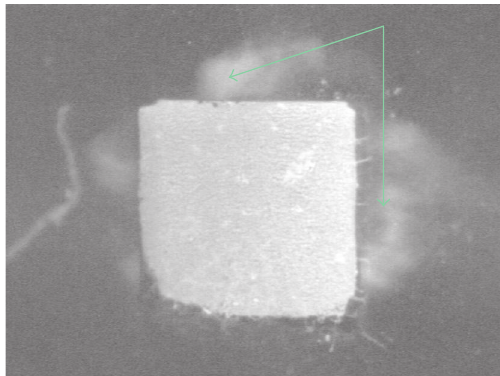
Figure 2: Collagen film surface after laser treatment ( F = 0 . 7 J/cm 2 , 10 pulses). Green arrows indicate a material deposition; black area represents nonirradiated region of the collagen film.